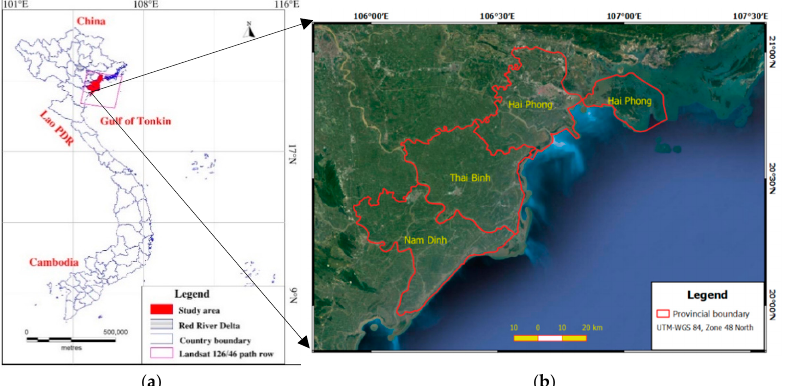
Figure 1. Study area in the northern coast of Vietnam: ( a ) map of Vietnam; ( b ) three coastal provinces in the RRD. The RRD, consisting of nine provinces (i.e., Hai Duong, Bac Ninh, Vinh Phuc, Hung Yen, Thai Binh, Nam Dinh, Ha Nam, Ninh Binh and Quang Ninh) is the second-largest delta and is located in the northern region of Vietnam with a total area of 15,000 km 2 . With a population of 22 million, the RRD is the most densely populated region in Vietnam [26].